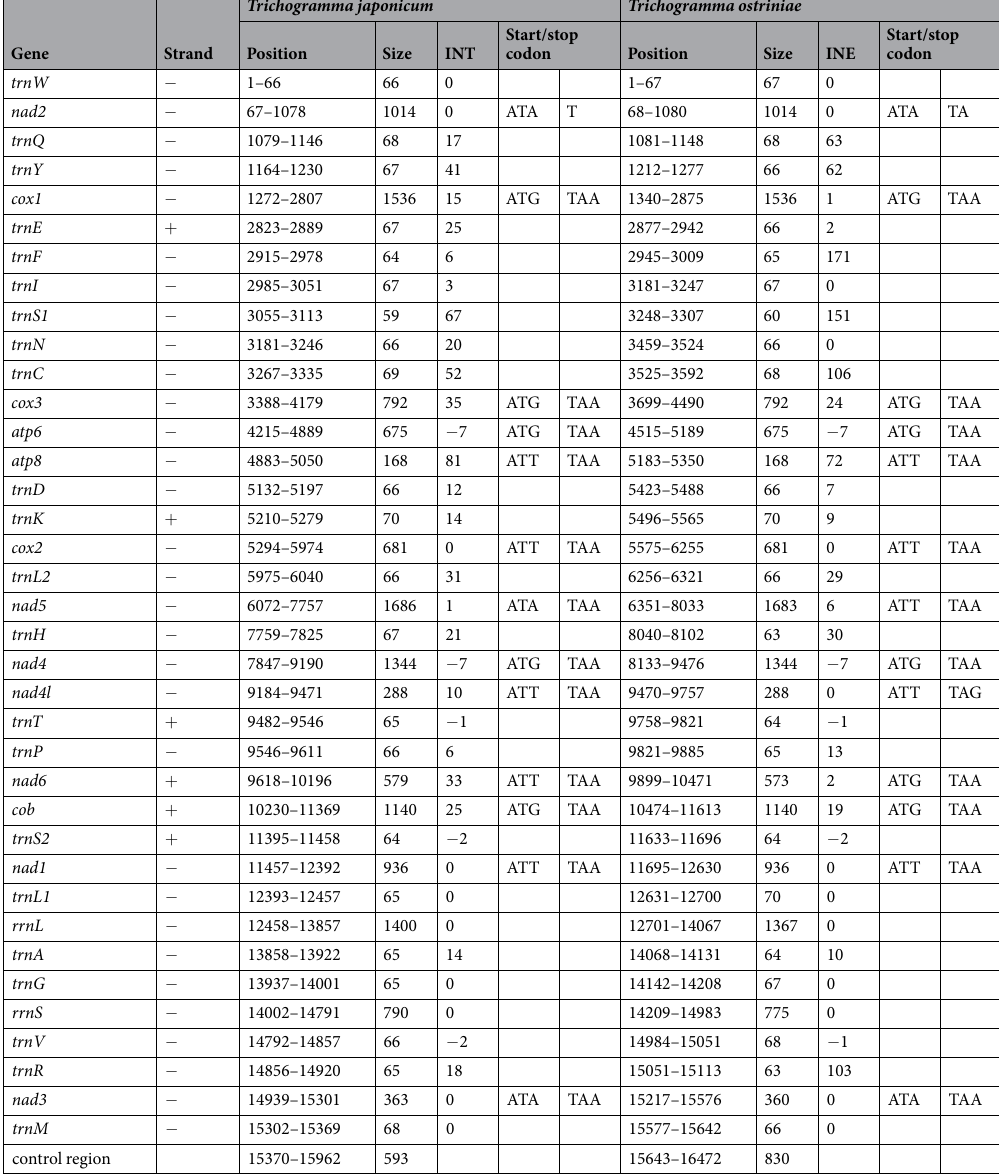
Table 1. Annotation of the Trichogramma japonicum and Trichogramma ostriniae mitochondrial genomes. + indicates the gene is coded on majority strand while − indicates the gene is coded on minority strand. INT indicates the intergenic nucleotides. Positive values indicate intergenic nucleotides and negative values indicate overlapping nucleotides between two adjacent